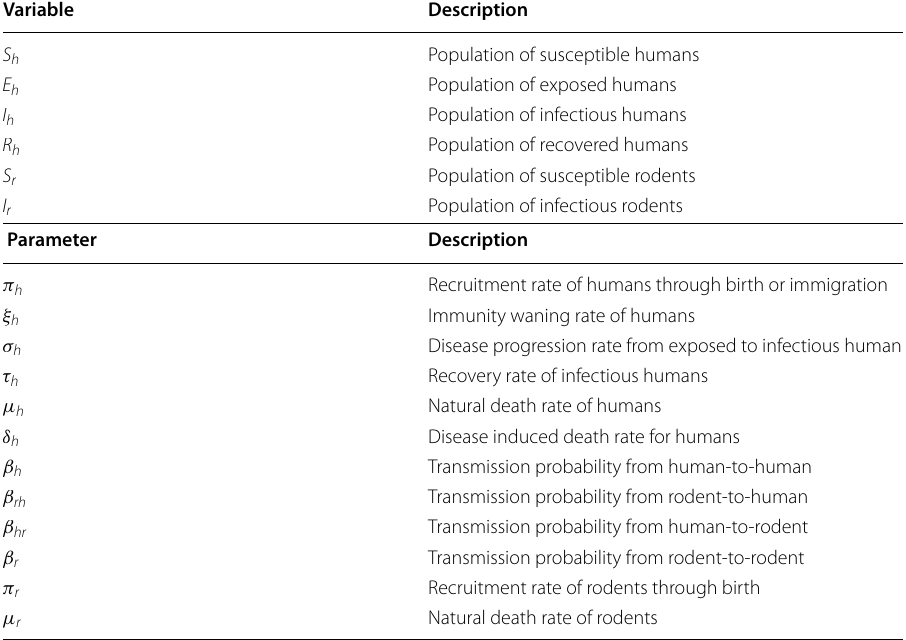
Table 1 Description of the variables and parameters of the Lassa fever model (1)